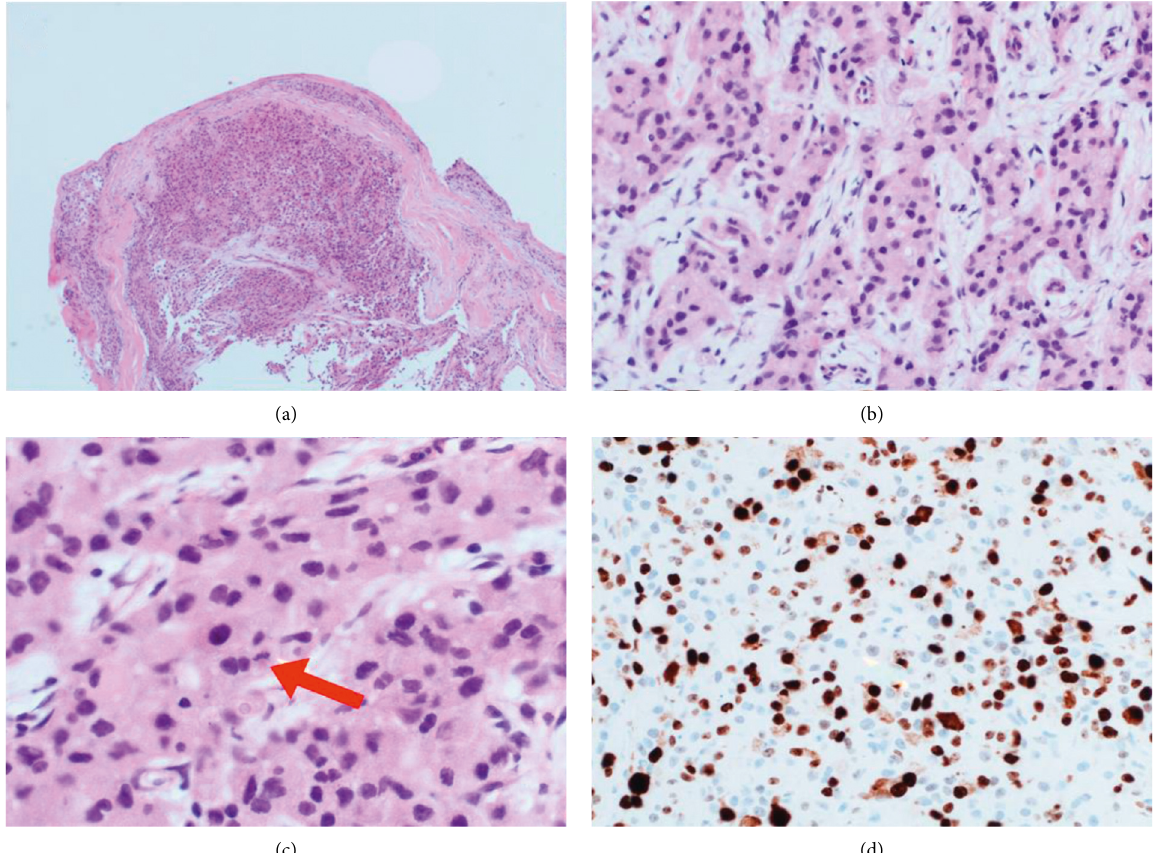
Figure 3: Photomicrographs of peritoneal nodule biopsy of Patient A. (a) Peritoneal nodule section (H&E × 40). (b) Tumor cells arranged in the cords and trabeculae (H&E × 200). (c) Hyperchromatic nuclei of tumor cells. The presence of mitosis was noted in a tumor cell (red arrow) (H&E × 400). (d) Ki-67 proliferative index was 50% (IHC ×